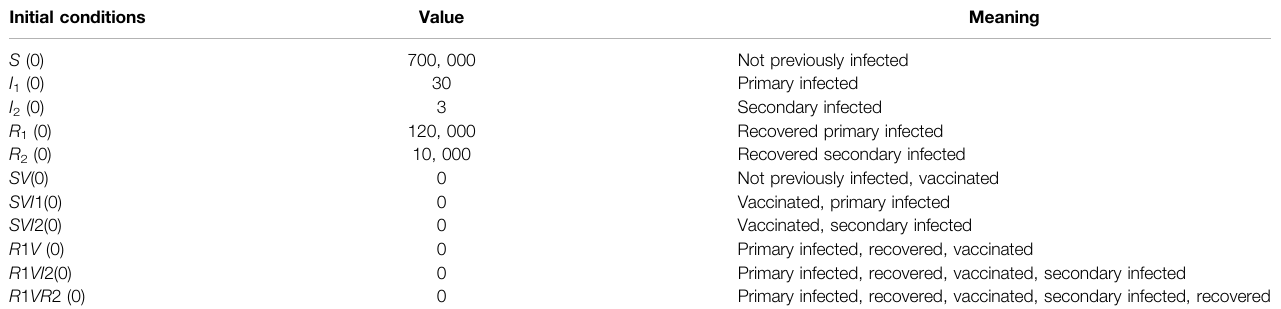
TABLE 5 | Initial conditions of the model. Time 0 corresponds to April 3, 2016.